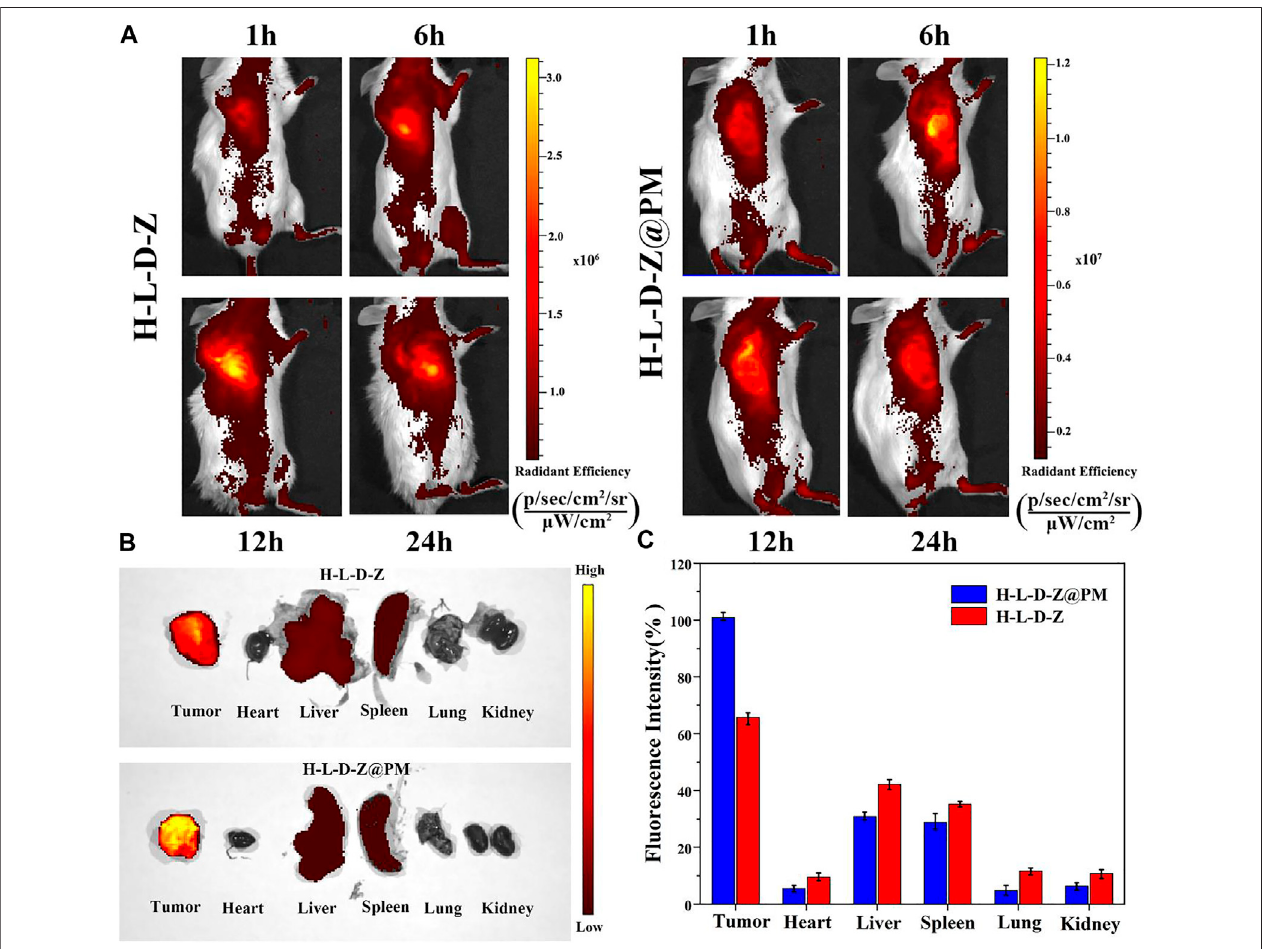
FIGURE5 | Tumor-targeting capacity ofH-L-D-Z NPsand H-L-D-Z@PM NPs. (A) In vivo fl uorescence imagingof mice received an intravenous injection ofIR780- labeled H-L-D-Z and H-L-D-Z@PM NPs. (B) Fluorescence images of organs harvested at 72 h post-injection. (C) Fluorescence intensity statistics of major organs in each treatment